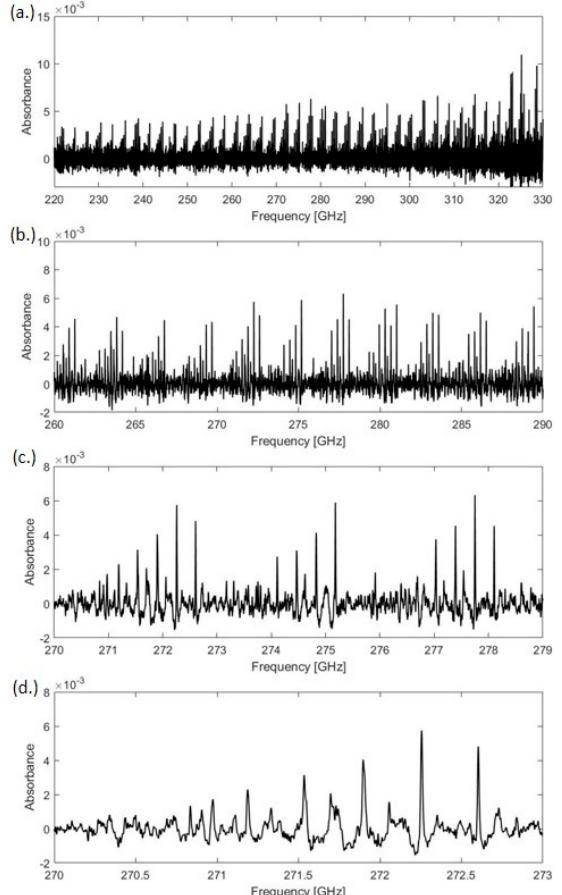
Figure 4. Measured absorbance for 0.4 Torr (53 Pa) pure DMSO at 297K in the frequency ranges of: ( a ) 220 – 330 GHz, ( b ) 260 – 290 GHz, ( c ) 270 – 279 GHz, and ( d ) 270 – 273 GHz.